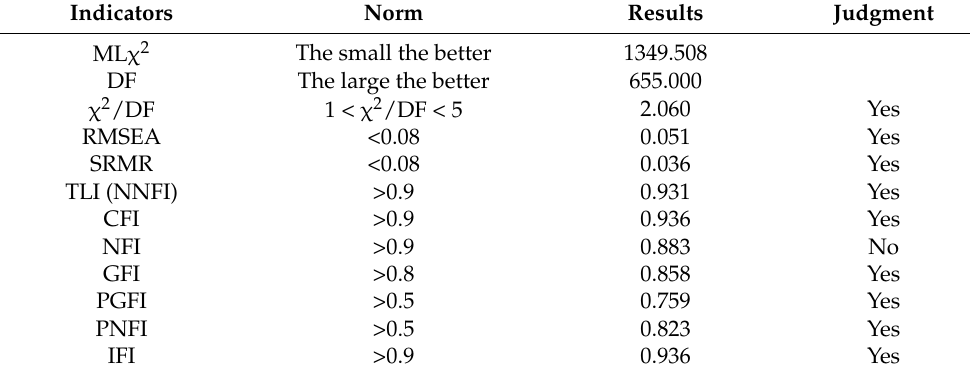
Table 6. Evaluation results.